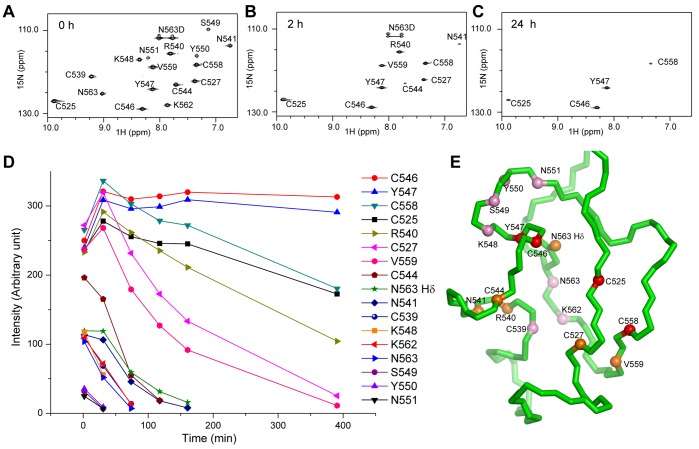
Amide proton exchange experiments.(A–C) 1H-15N HSQC spectra collected immediately (A), 2 h (B) or 24 h (C) after dissolving the lyophilized CXC-3 protein in 2H2O. The peaks are labeled and the side chain amide proton Hδ of N563 is labeled as N563D. (C) Intensity of amide proton peak as a function of exchange time. (D) Distribution of slow exchange amide protons in the CXC domain structure. The protected amide protons are shown as spheres on a backbone trace and are colored pink if present in the first recorded spectrum but not after 2 h, orange if present at 2 h but not after 24 h, and red if present after 24 h. The side chain of N563 is also displayed.